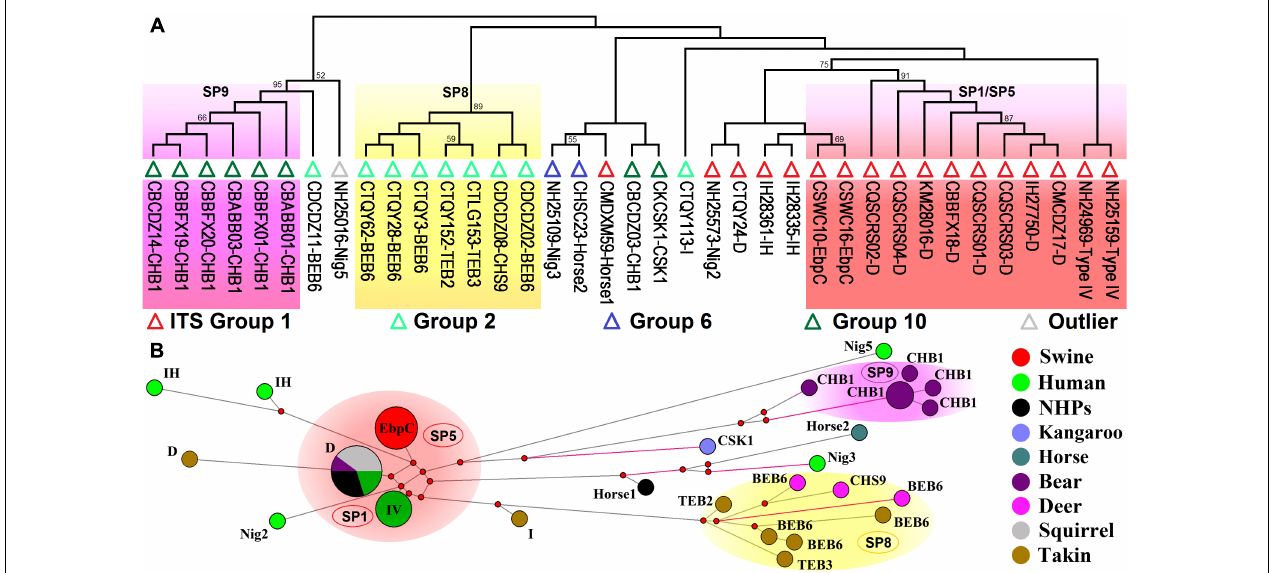
FIGURE 3 | Multilocus phylogeny and haplotype network of Enterocytozoon bieneusi isolates from different hosts and geographic origins that belong to Group 1 and several other ITS groups. All the E. bieneusi isolates ( n = 20) that belong to the ITS groups other than Group 1 were included in the analyses and some of the Group 1 isolates ( n = 27) with genotypes being D, EbpC, type IV, horse1, IH, and Nig2 were selected for comparative analysis (Supplementary Table S2). Panel A : Maximum-parsimony phylogeny of 37 unique multilocus genotypes (MLGs) generated considering both single-nucleotide polymorphisms (SNPs) and insertions and deletions from the total isolates using Mega 7 (http://www.megasoftware.net/). The first initials of isolate names, C, I, and N, indicate the isolates were sampled in China, India, and Nigeria, respectively. The letters B, D, H, K, M, Q, S, and T followed indicate the isolates were sampled from bear, deer, human/horse (only human from India and Nigeria was sampled, and horse from China likewise), kangaroo, monkey, squirrel, swine, and takin, respectively. ITS genotypes are labeled at the ends. ITS Groups 1, 2, 6, and 10 and an outlier group that the isolates belong to were indicated by red, light green, blue, dark green, and gray triangles, respectively. Bootstrap values above 50% from 1,000 pseudoreplicates are displayed. Panel B : Median-joining network analysis of all the total 47 isolates using Network 4.6.1.1 (http://www.fluxus-engineering.com/sharenet_rn.htm). The colors in circles represent various host sources. The size of the circles is proportional to the frequency of each of the 26 MLGs obtained based on only SNPs. ITS genotypes are labeled beside the circles. Genotype type IV is abbreviated as IV for better presentation and non-human primates as NHPs likewise. The black branches connecting MLGs have a length proportional to the SNPs, while the red branches having pairwise differences greater than 12 SNPs are shortened for better